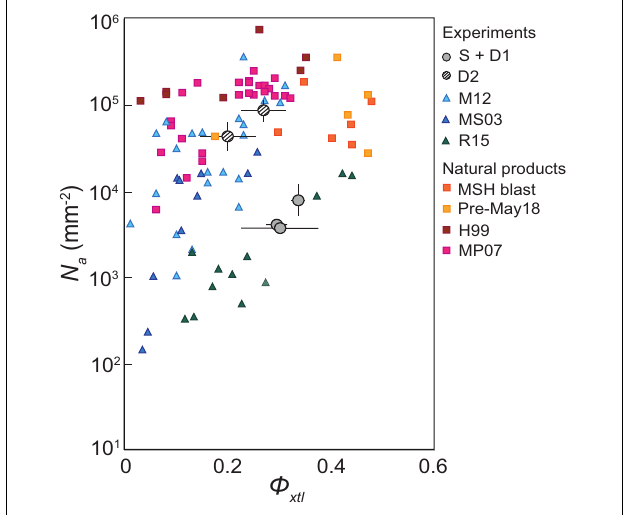
FIGURE 4 | Textural data from experimental samples and eruption products compared with this study. Counting parallel microlites in static (S) and D1(recompression) experiments as single crystals ( Supplementary Figure 3 ) results in number densities similar to the experimental study of Riker et al. (R15; 2015b). An apparent increase in crystallinity due to broken dendrites accounts for the order of magnitude difference in experimental (D2) samples. D2 experiments are comparable to MSH blast dacite (MSH blast) and ash (Pre-18 May) samples. Data from additional experimental samples are